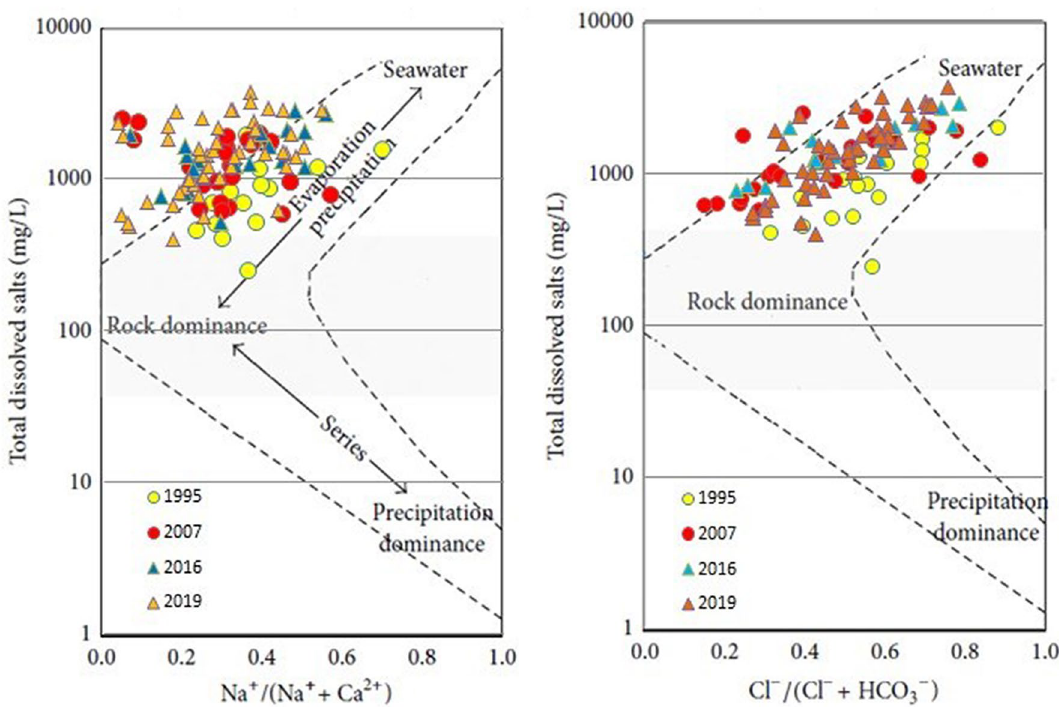
Fig. 8 Gibbs diagrams for the major ion composition of the groundwater in the study